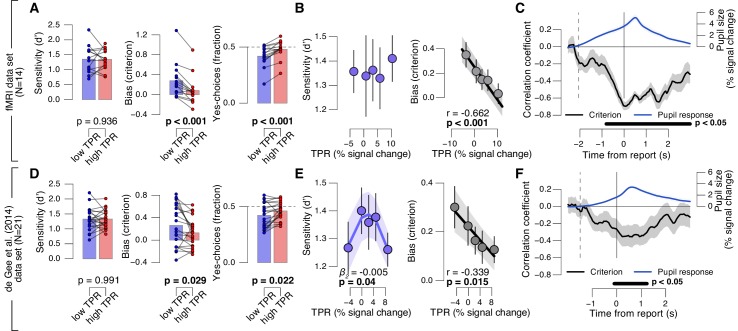
Phasic arousal predicts reduction of choice bias.(A) Perceptual sensitivity SDT d’ (left), decision bias, measured as SDT criterion (middle) or fraction of ‘yes’-choices (right), for low and high TPR. For the fraction of ‘yes’-choices analysis, we ensured that each TPR bin consisted of an equal number of signal+noise and noise trials (see Materials and methods). Data points, individual subjects. (B) Relationship between TPR and d’ or criterion (5 bins). Linear fits are plotted wherever the first-order fit was superior to the constant fit (see Materials and methods). Quadratic fits are plotted wherever the second-order fit was superior to first-order fit. (C) Sliding window linear correlation between TPR and SDT criterion (5 bins), aligned to button press. Dashed line, median decision onset (cue). The group average pupil response time course is plotted for reference in blue. (D–F) As panels A-C, for an independent data set (de Gee et al., 2014). All panels: group average (N = 14 and N = 21); shading or error bars, s.e.m.; stats, permutation test.DOI:
http://dx.doi.org/10.7554/eLife.23232.00510.7554/eLife.23232.006Figure 2—source data 3.Table with variable identifiers used in Figure 2—source data 1 and 2.DOI:
http://dx.doi.org/10.7554/eLife.23232.00610.7554/eLife.23232.007Figure 2—source data 1.This csv table contains the data for Figure 2 panel A.DOI:
http://dx.doi.org/10.7554/eLife.23232.00710.7554/eLife.23232.008Figure 2—source data 2.This csv table contains the data for Figure 2 panel D.